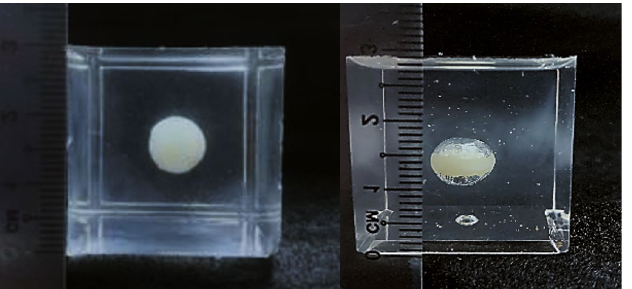
Figure 8. Spherical TPU inclusion embedded in silicone matrix before ( left ) and after ( right ) programming via compression in the vertical direction.